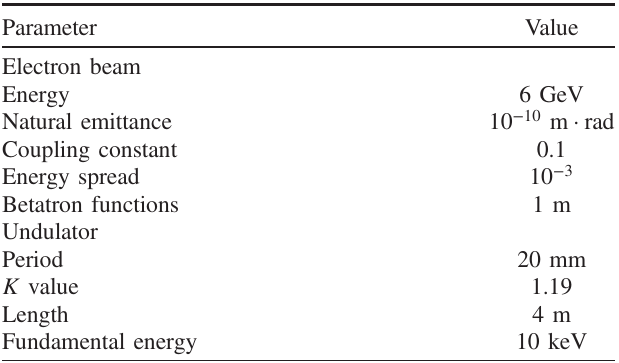
TABLE I. Electron beam and undulator parameters used in the computation to optimize the betatron